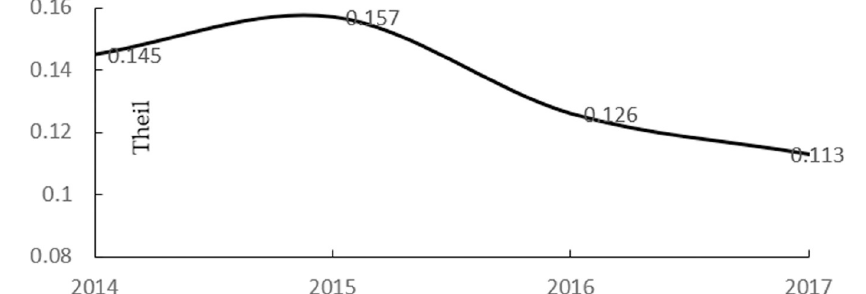
Fig 5. Market values in different sites. Grids with red colours were regions with high market values. Grids with orange colours were regions with moderate market values and grids with transparent colours were regions with low market values.